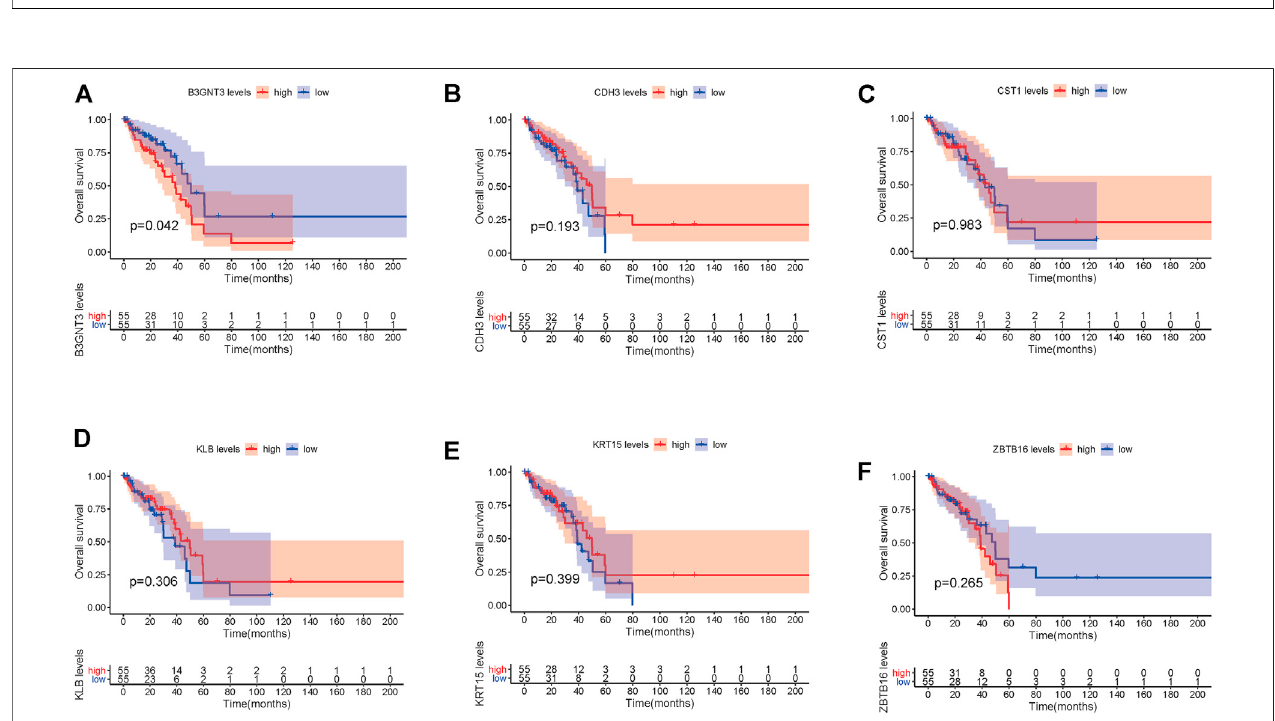
FIGURE5| TCGA database wasused tolookat theoverall survival(OS)of6hubgenesinEGFR-MTLUADpatients. (A) SurvivalanalysisforB3GNT3. (B) Survival analysis for CDH3. (C) Survival analysis for CST1. (D) Survival analysis for KLB. (E) Survival analysis for KRT15. (F) Survival analysis for ZBTB16. The patients were strati fi ed intothe high-levelgroup(red) and low-levelgroup (blue) accordingtothe median expression ofthe gene. Log-rank p < 0.05wasconsidered tobe astatistically signi fi cant difference.